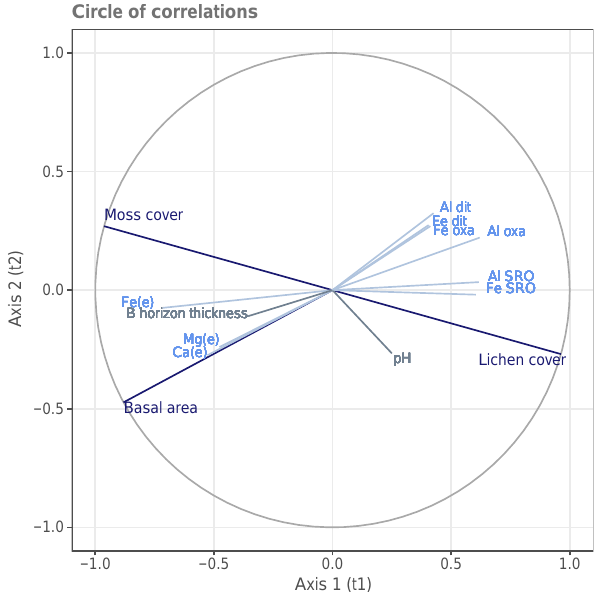
Figure 7. Graphical projection of partial least squares canonical analysis (PLSCA) results in the B horizon at the plot scale. Vari- ables for stand tree cover characteristics are drawn in dark blue, chemical compounds in light blue and soil characteristics in grey. Axes correspond to principal orthogonal canonical components. Positive, null or negative correlations between variables are indi- cated by acute, right or obtuse angles, respectively, between the cor- responding vectors. “(e)” indicates exchangeable or extractable ele- ments. Regarding the chemical elements, only variables that showed the greatest differences in mean values between lw and mf plots in the B horizon were included in the PLSCA.